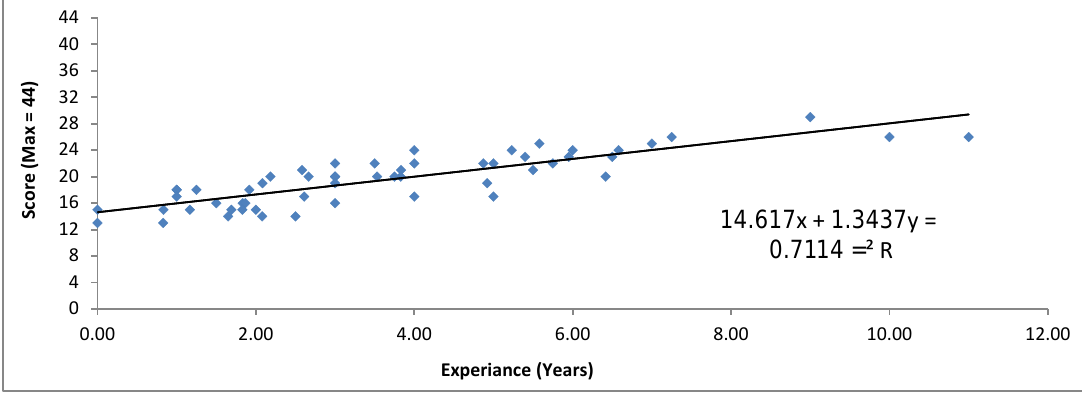
Fig. 5. Pre-test score results of students who pursue the Industrial Engineering master